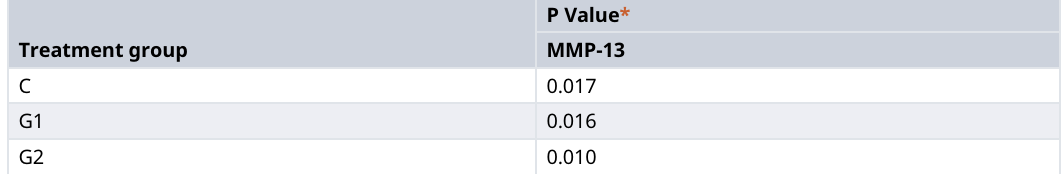
Table 2. Differentiation of each treatment groups by observation times on Day 3, Day 7, and Day 14.